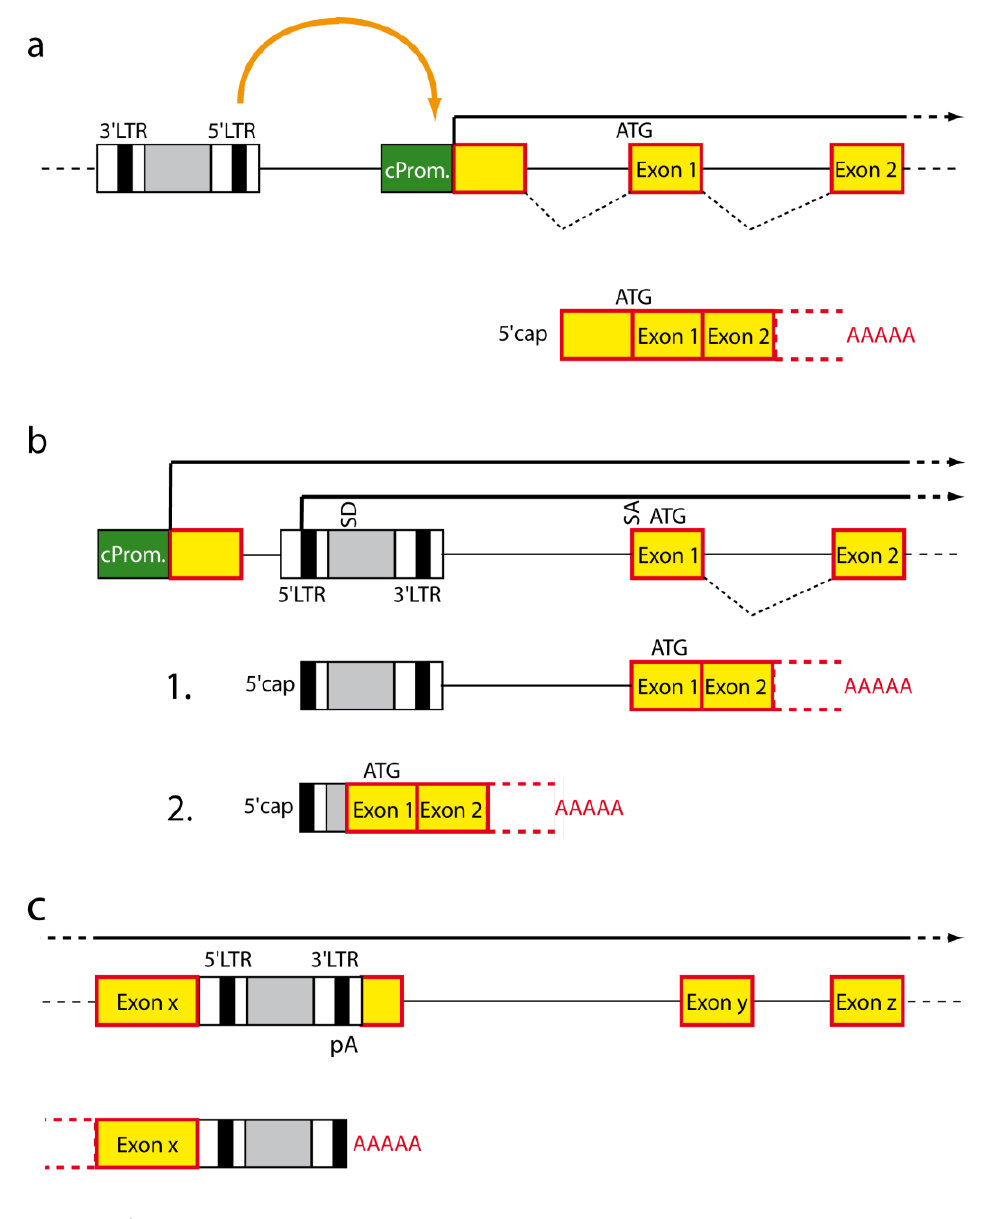
Figure 6. Modes of insertional mutagenesis. ( a ) Vector insertion in reverse orientation upstream of a cellular gene leads to enhancer-mediated upregulation of cellular gene expression. ( b ) Integration between the promoter and the first coding exon uncouples the cellular transcription unit from its promoter and facilitates expression from the viral promoter. Read-through the 3’ pA signal of the virus leads to fusion transcripts that can either remain unchanged or undergo splicing. ( c ) Integration into a transcription unit can mediate pre-mature termination due to usage of pA signals located within the proviral DNA. Green box, cellular promoter; red box, coding exon; LTR, long terminal repeat; ATG, start codon; SD, splice donor; SA, splice acceptor; A , pA n